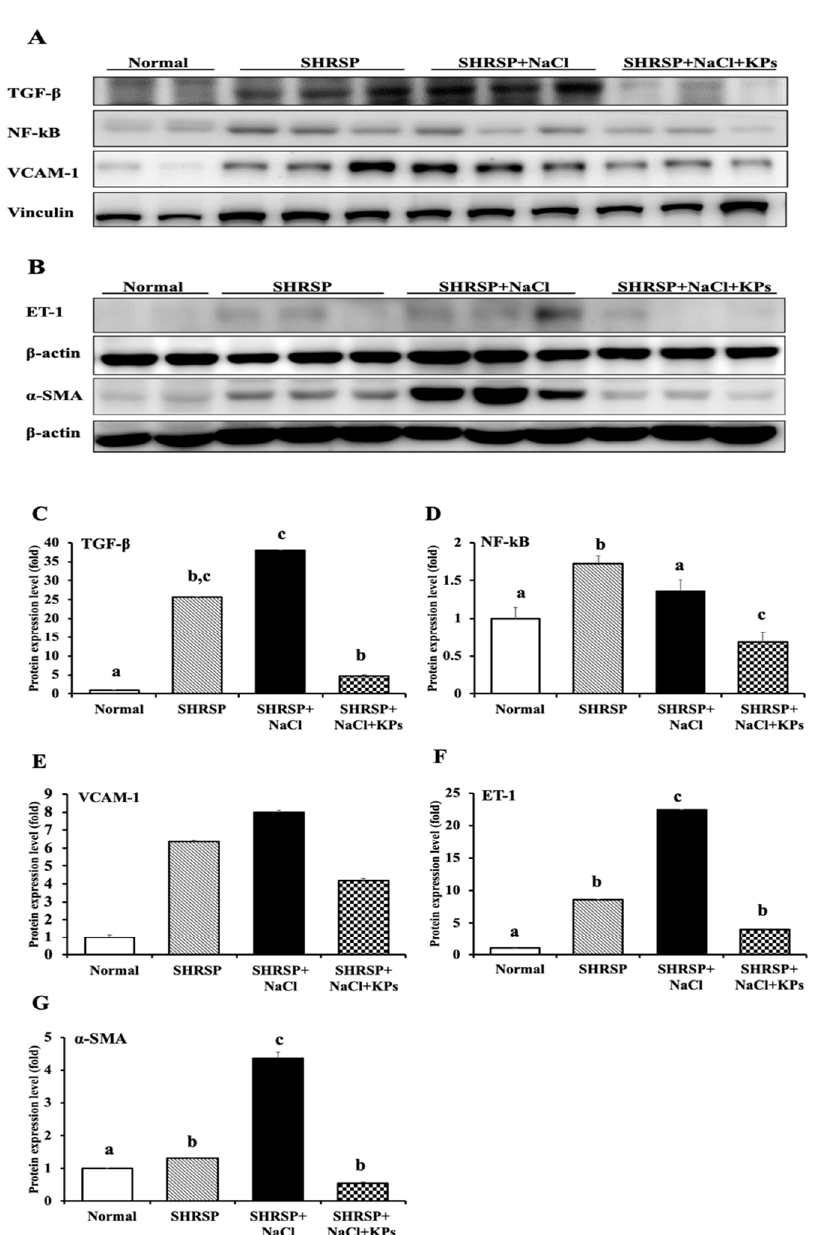
Figure 6. Effect of KPs on inflammation and endothelial and fibrosis biomarker expression in the kidney tissues of WKY and SHRSP rats, as determined by Western blot analysis. ( A ) The levels of inflammatory factors (TGF- β and NF- κ B) and a renovascular adhesion molecule (VCAM-1) were increased in the kidney tissues of SHRSP rats with or without salt induction compared to the WKY (normal) rats but reduced in the SHRSP+NaCl+KPs group after the KPs treatment. ( B ) The levels of a fibrosis biomarker ( α -SMA) and endothelial biomarker (ET-1) were increased in the kidney tissue of the SHRSP+NaCl group compared to the WKY (normal) rats and the SHRSP group. The high α -SMA and ET-1 expressions in the SHRSP+NaCl group were reversed by the KPs treatment (SHRSP+NaCl+KPs group). Quantitative analyses of the results of the Western blot analysis of TGF- β ( C ), NF- κ B ( D ), VCAM-1 ( E ), ET-1 ( F ), and α -SMA ( G ) were carried out with ImageQuant TM TL8.1 analysis software. Data are presented as the means ± SEMs (Normal, n = 5; SHRSP, n = 5; SHRSP+NaCl, n = 6; SHRSP+NaCl+KPs, n = 6) and were analyzed by one-way ANOVA. Data within columns that are not labeled with the same letter are significantly different ( p < 0.05), as determined using Duncan’s test.